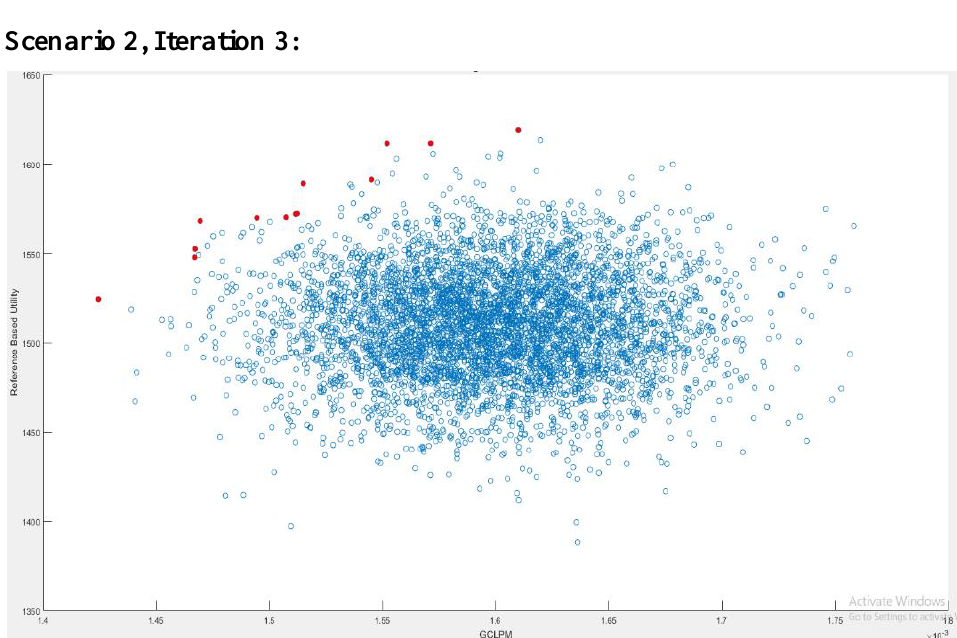
Figure 8. The Result Of Investigation Of 5,000 Different Portfolios In Third Iteration Of Scenario 2